Question: Give a one-sentence summary of this figure.
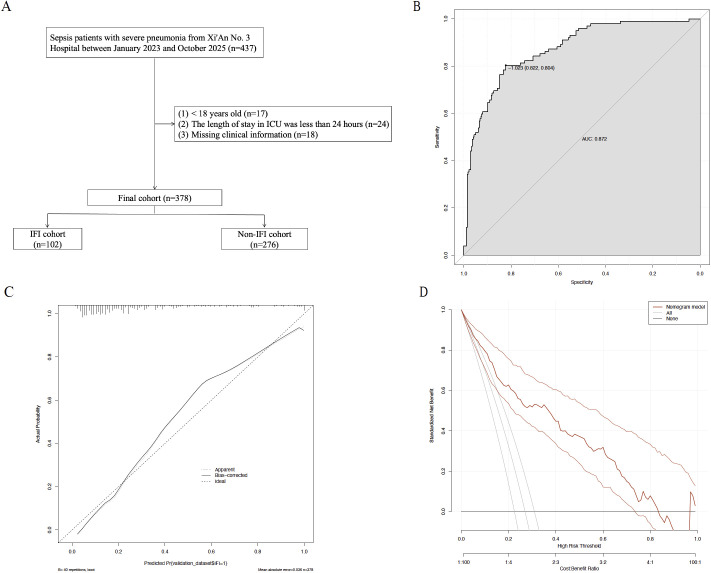
Answer: External validation of the predictive nomogram. (A) Flowchart illustrating patient selection at Xi’an No. 3 Hospital. (B) Receiver operating characteristic (ROC) curve of the nomogram for IFI prediction in the external validation cohort. (C) Calibration curve demonstrating agreement between predicted probabilities and observed outcomes. (D) Decision curve analysis (DCA) assessing the clinical utility of the nomogram in the external validation set.